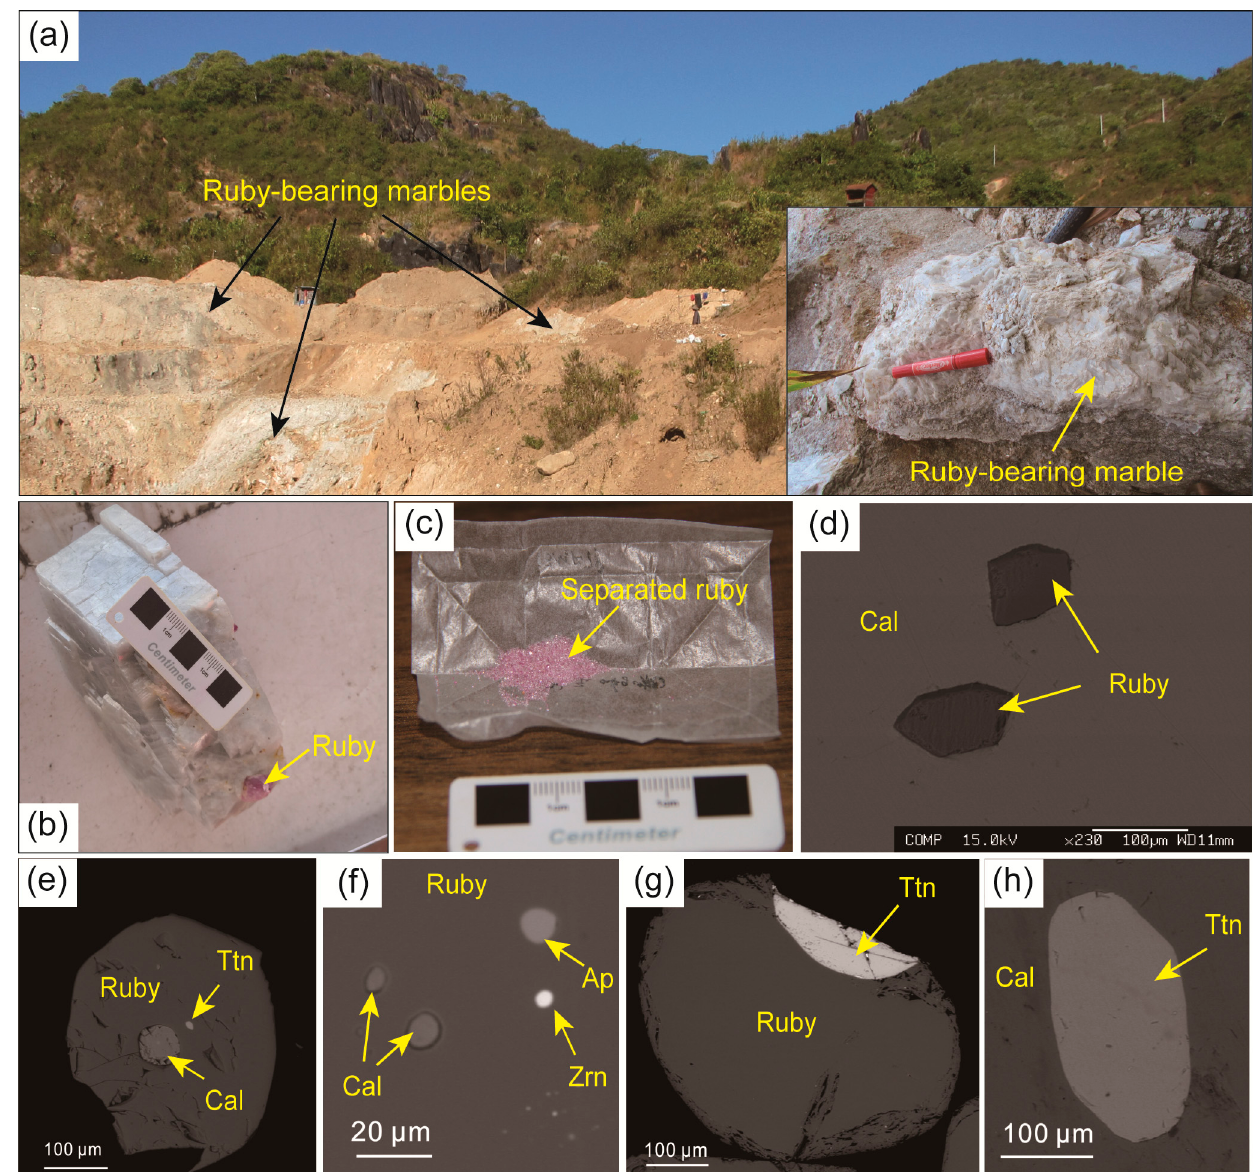
Figure 2. Field views ( a ) specimen photographs ( b , c ) and backscattered electron images ( d – h ) showing the occurrence of ruby ‐ bearing marbles and the textural characteristics of ruby crystals. ( a ) Field views of ruby ‐ bearing marbles. Inserted image showing the investigated coarse ‐ grained marbles. ( b ) Deep pink ruby crystal in the marble. ( c ) Ruby grains separated from the ruby ‐ bearing marble. ( d ) Subhedral to euhedral ruby crystals in the coarse ‐ grained marble. ( e ) Calcite and tiny titanite inclusions in ruby. ( f ) Small calcite, apatite, and zircon inclusions in ruby. ( g ) Titanite inclusion in ruby. ( h ) Anhedral titanite without sector zones in marble. Mineral abbreviations [44]: Cal, calcite; Ttn, titanite; Ap, apatite; Zrn, zircon.